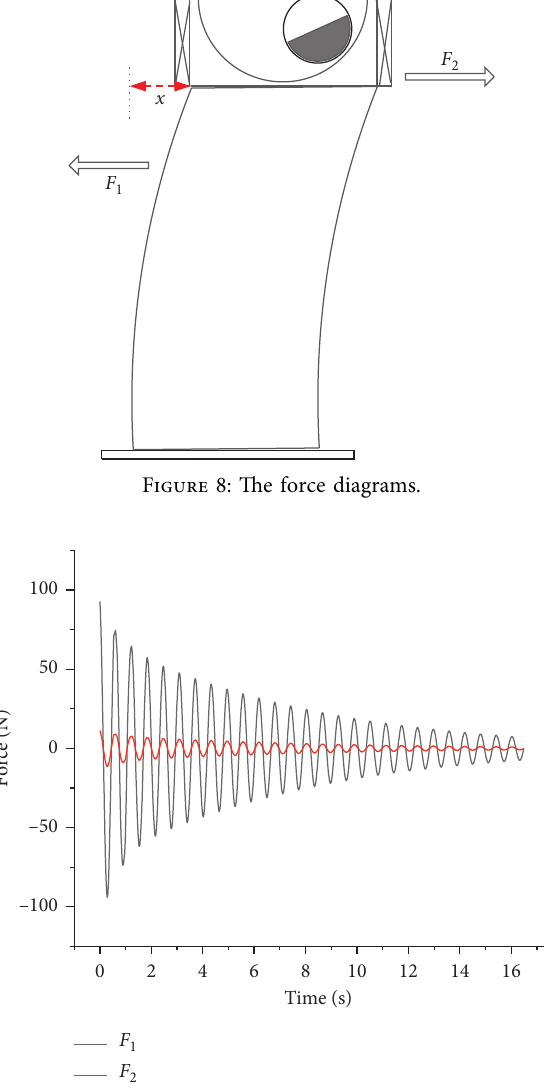
Figure 9: The curves of F 1 and F 2 under free